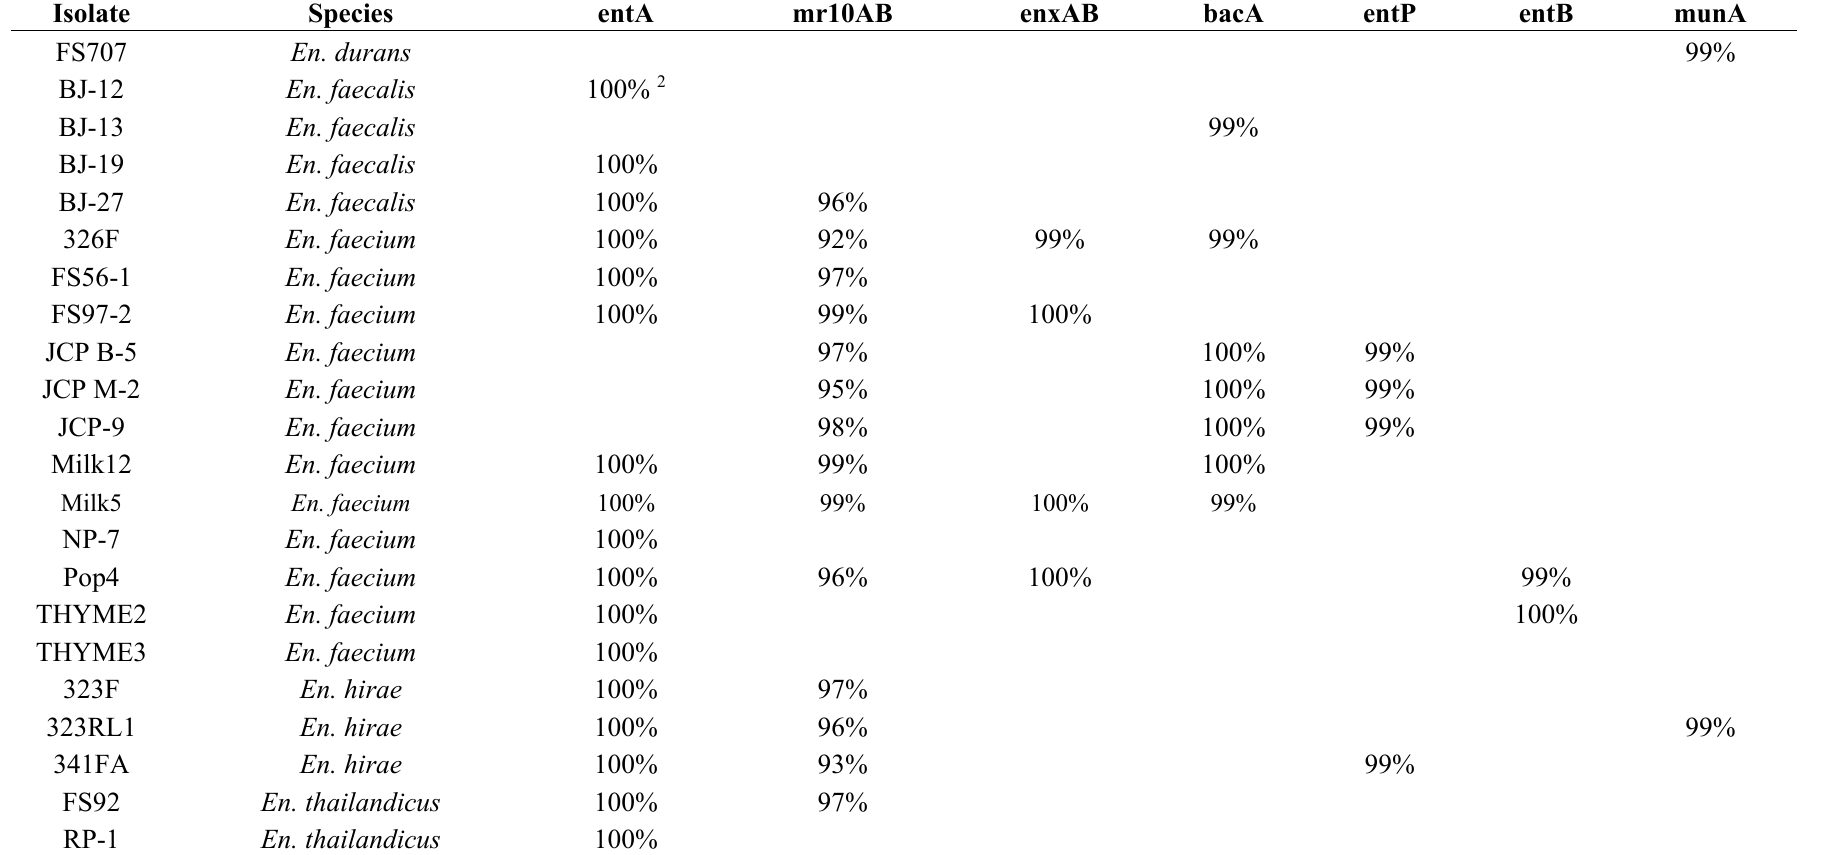
Table 2. Enterococcus strains used in this study and highest sequence homology 1 of partially sequenced bacteriocin operons to known bacteriocin operons.